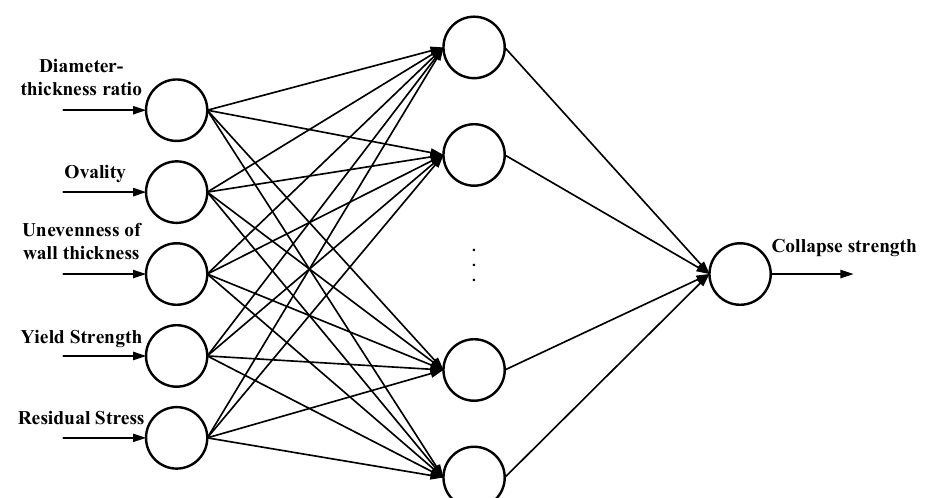
Figure 7. Neural network structure for prediction the casing collapse strength.